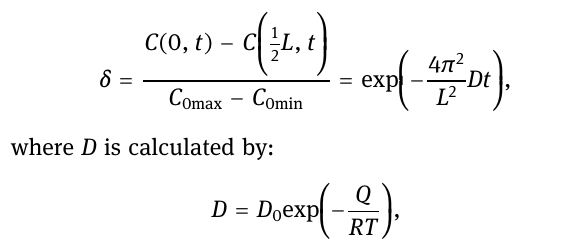
Figure 11: Schematic diagram of cosine distribution of element concentration.